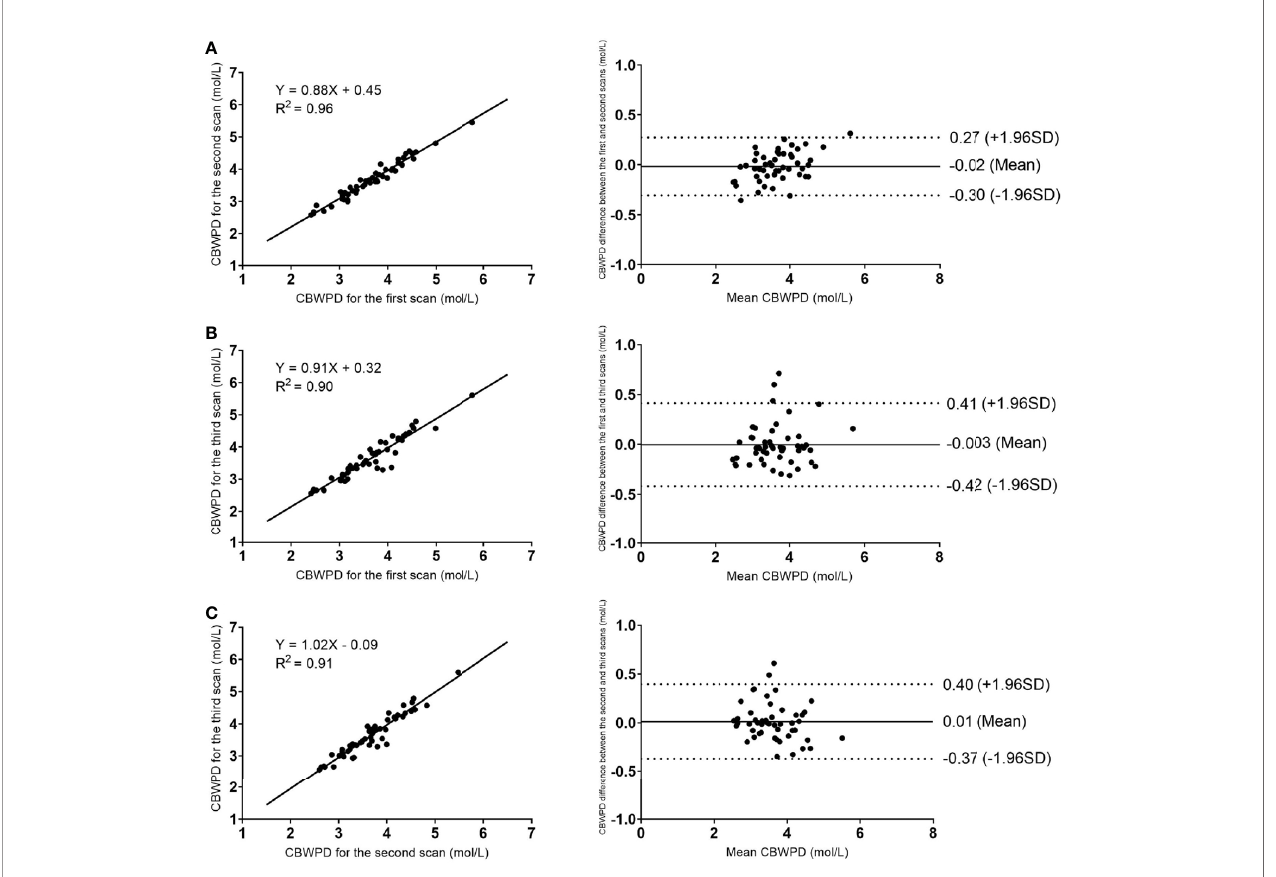
FIGURE 2 | Reproducibility results of the STAIR-UTE Cones scans: linear regression (left column) and Bland – Altman analysis (right column) plots of the STAIR-UTE measured CBWPDs between the fi rst and the second scans (A) , between the fi rst and the third scans (B) , and between the second and the third scans (C) . Dotted lines in the Bland – Altman difference plots (right column) demarcate 1.96 standard deviations of the mean